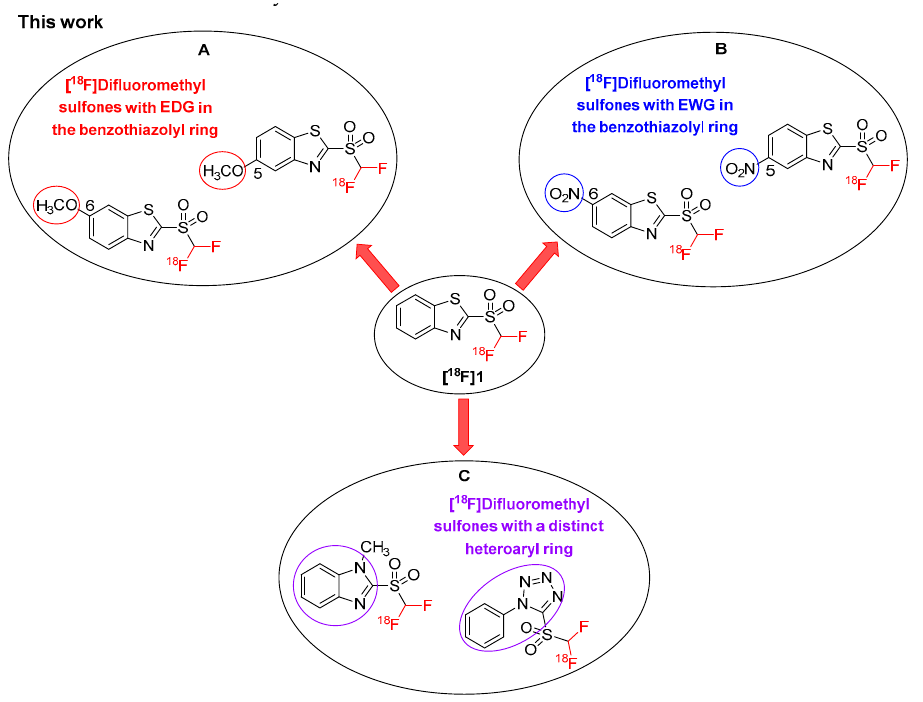
Figure 2. Molecular modifications performed on [ 18 F]1 : introduction of a single electron-donating (OCH 3 ) ( A ) or electron-withdrawing (NO 2 ) ( B ) substituent either at position 5 or 6 of the benzothiazolyl ring, and modification of the original benzothiazolyl moiety to other heteroaryl rings ( C ).